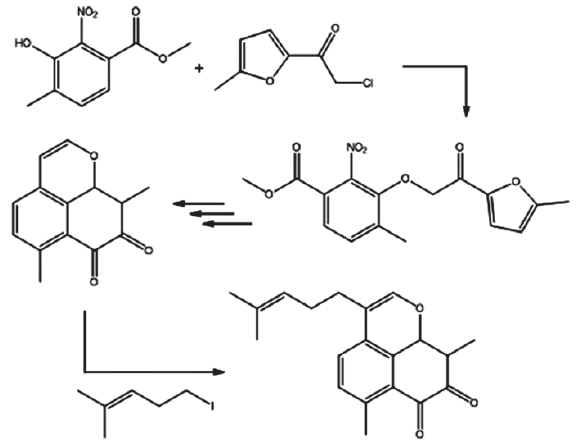
Figure 4 - Schematic representation of the chemical synthesis of biflorin presented by Best and Wege